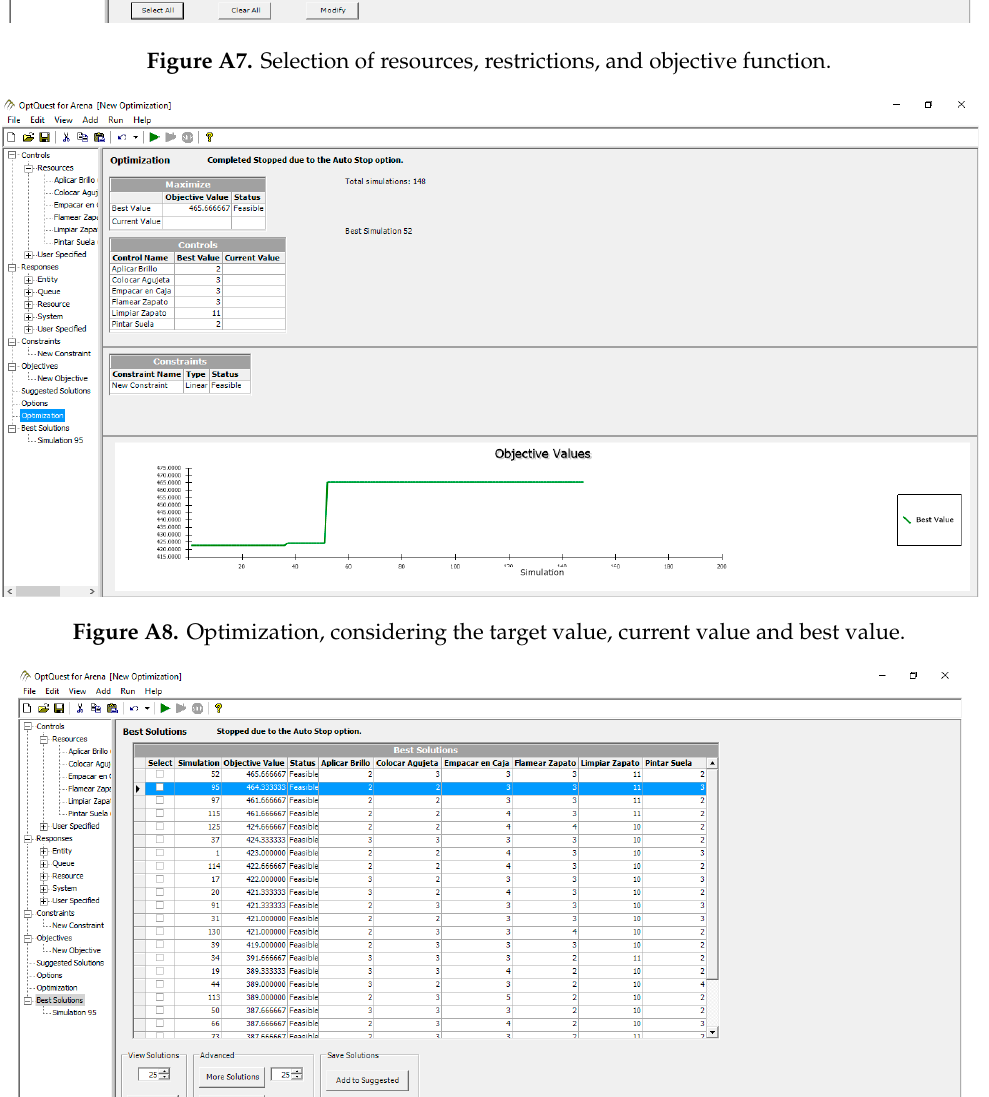
Figure A9. Comparison of results. In simulation 52, the best value is obtained with 466 pairs of